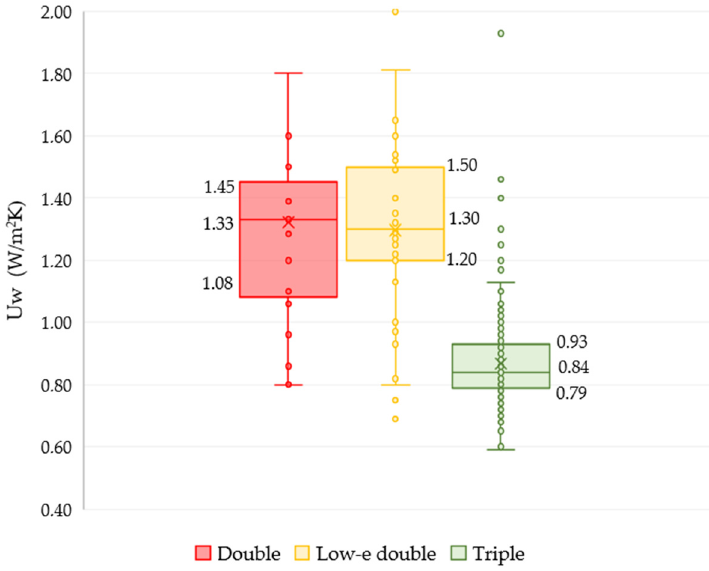
Figure 12. Thermal transmittance according to the type of window glass.